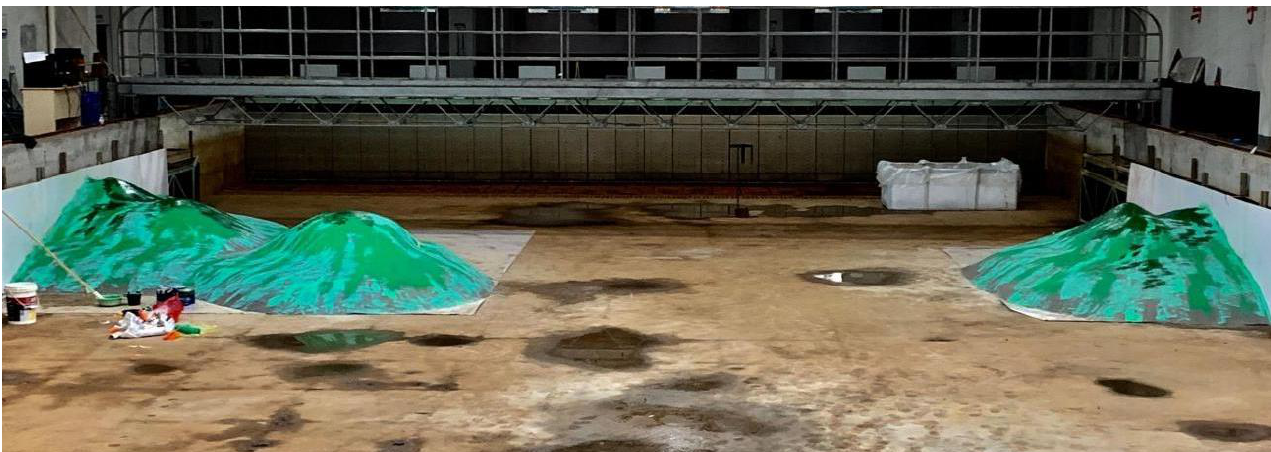
Figure 17. Reefs model diagram.